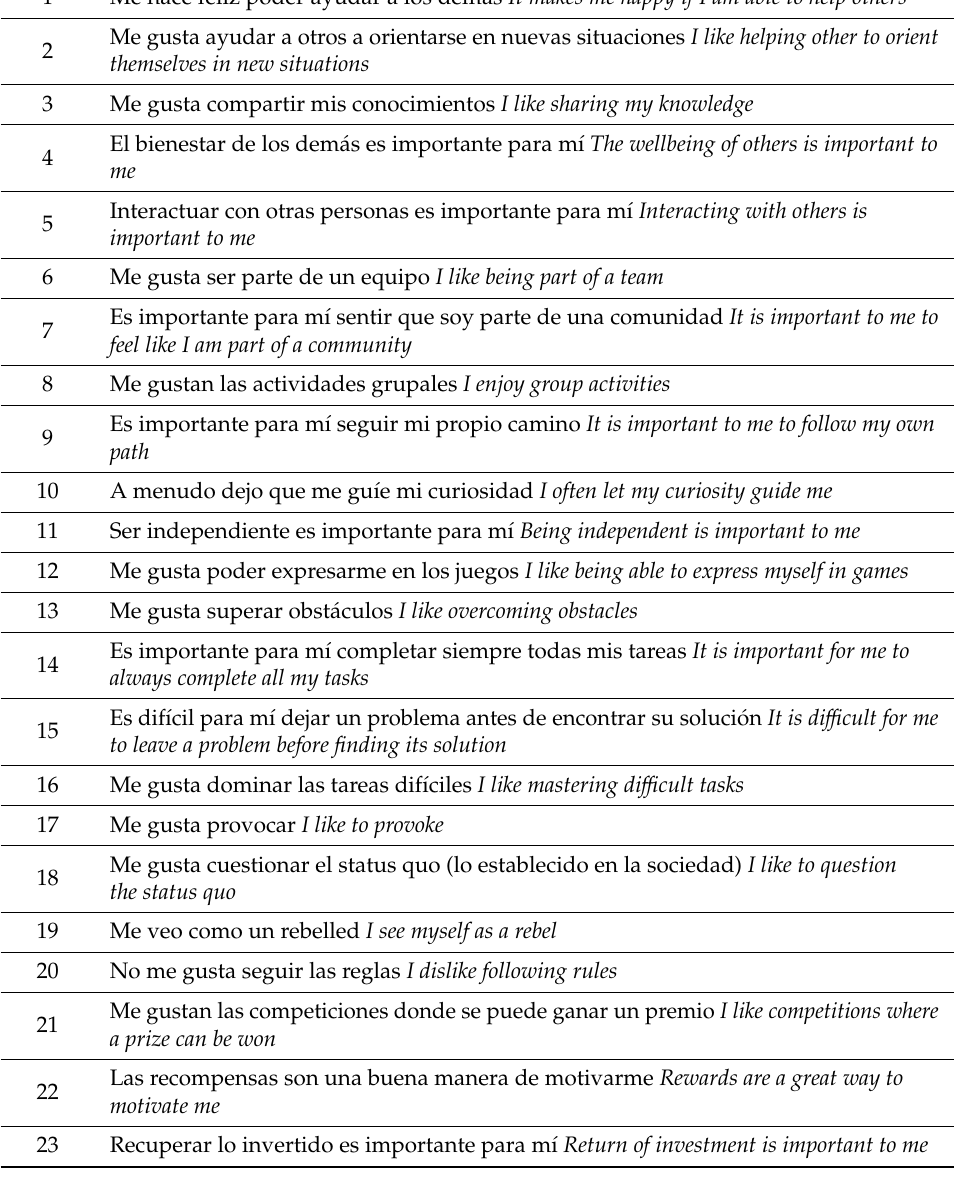
Table A1. This questionnaire was validated in